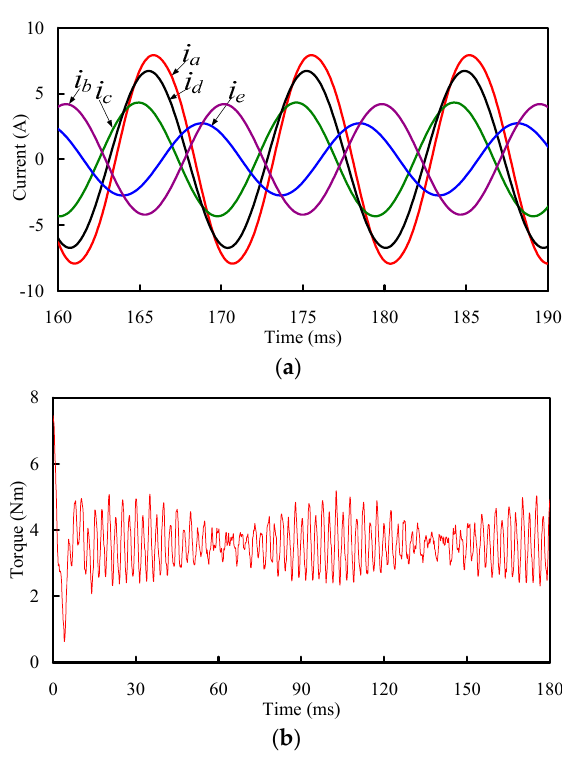
Figure 6. Performance under fault ‐ tolerant condition: ( a ) Currents; ( b ) Output torque.